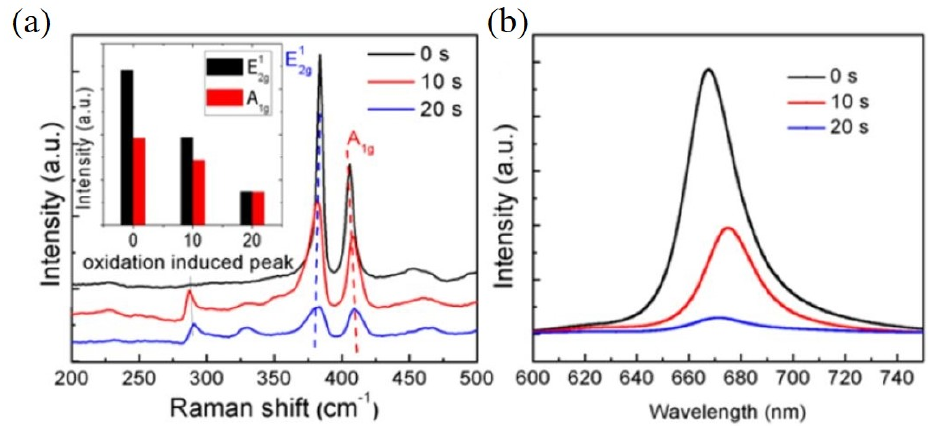
Figure 2. ( a ) Raman and ( b ) PL spectra of single-layer MoS 2 show that the peak intensity and position decrease and shift, respectively, with different oxygen plasma exposure times [37].